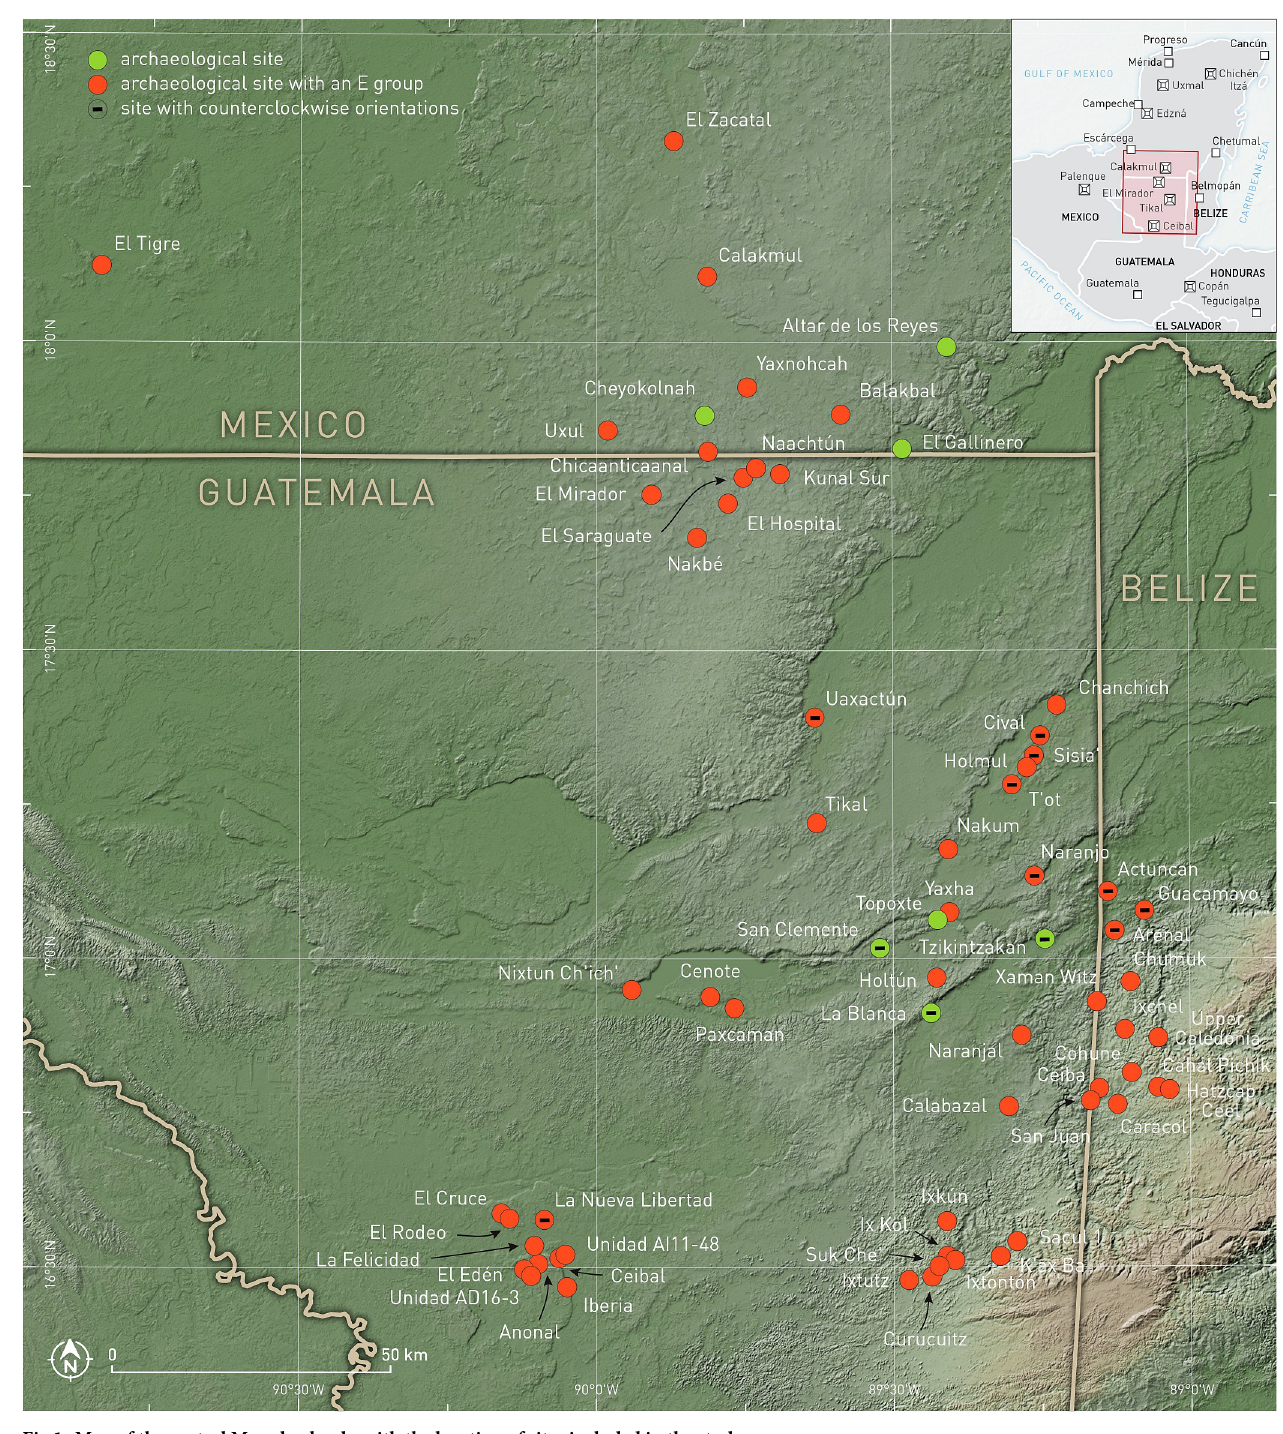
Fig 1. Map of the central Maya lowlands, with the location of sites included in the